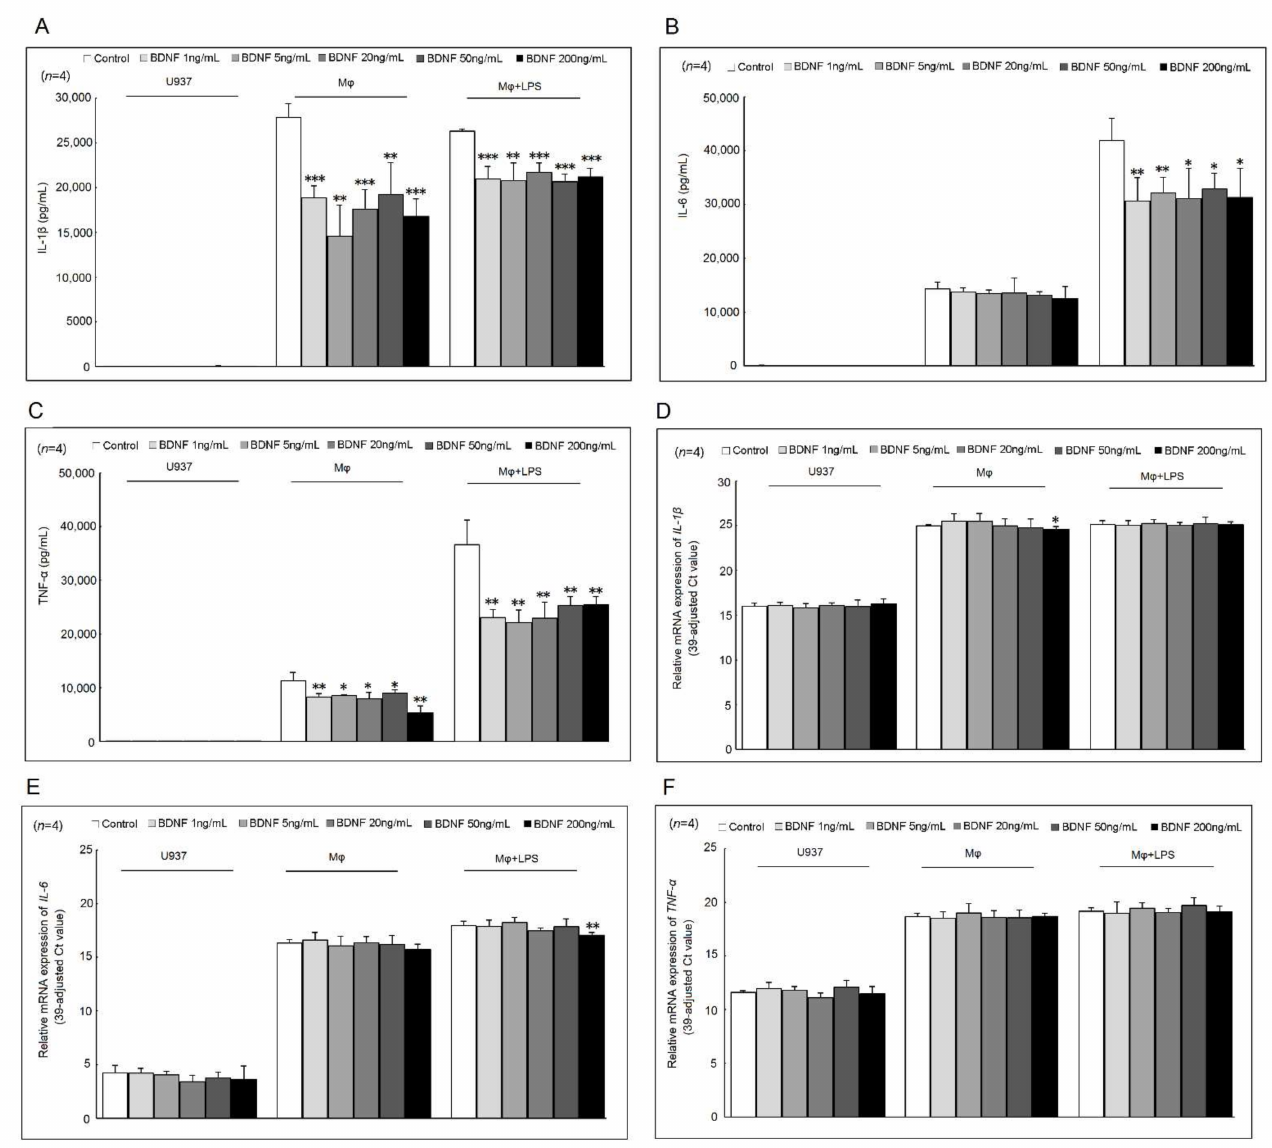
Figure 1. Effects of BDNF on IL-1 β , IL-6, and TNF- α secretion and mRNA expression. U937 cells, differentiated macrophages, and LPS-stimulated macrophages were cultured with different concentrations of BDNF (0, 1, 5, 20, 50, and 200 ng/mL) for 48 h (for cytokine secretion) or 4 h (for mRNA expression). The effects of different concentrations of BDNF for the secretion of ( A ) IL-1 β , ( B ) IL-6, and ( C ) TNF- α in U937 cells, differentiated macrophages, and LPS-stimulated macrophages. The effects of different concentrations of BDNF for the mRNA expression of ( D ) IL-1 β , ( E ) IL-6 , and ( F ) TNF- α in U937 cells, differentiated macrophages, and LPS-stimulated macrophages (* p < 0.05; ** p < 0.01; *** p <